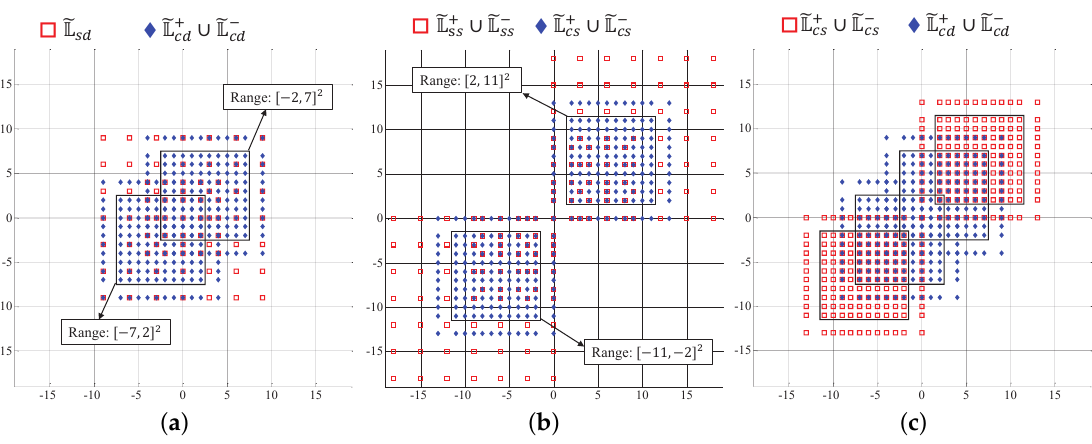
Figure 4. An example of coarrays of CAACS, where M 1 = 4, M 2 = 3 and p = 2. ( a ) The difference coarray. ( b ) The sum coarray. ( c ) The cross-diff-sum